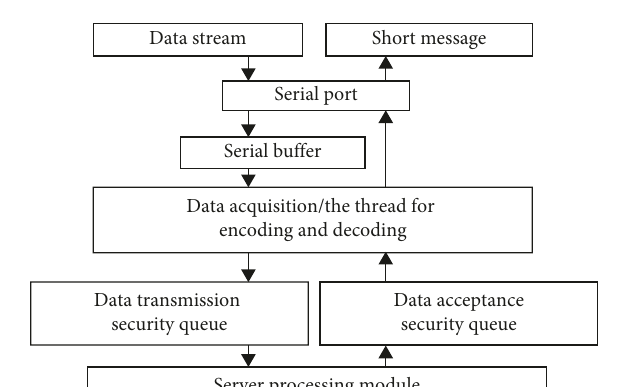
Figure 2: Software structure diagram.